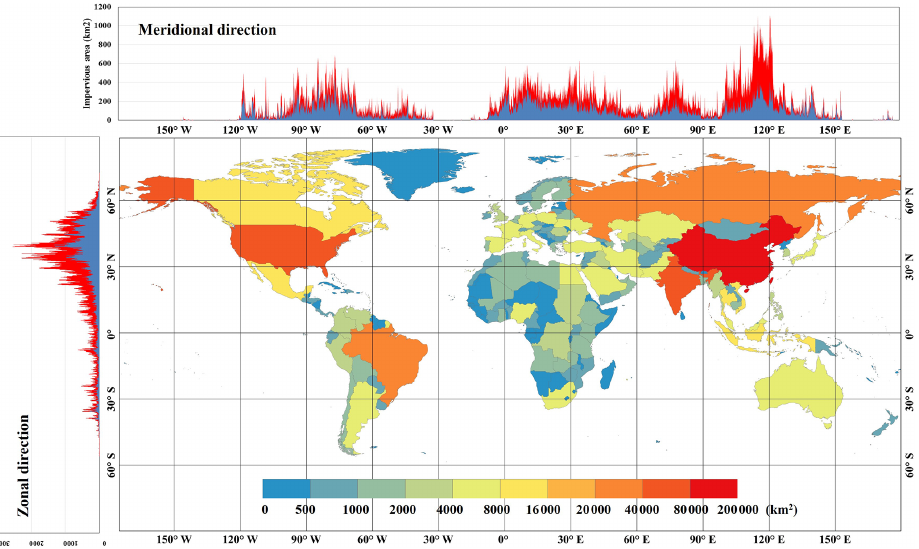
Figure 7. The expansion of impervious area in each country over the period 1985–2020 and meridional and zonal impervious-area statistics for 1985 (blue) and 2020 (red), with a step of 0.05 ◦